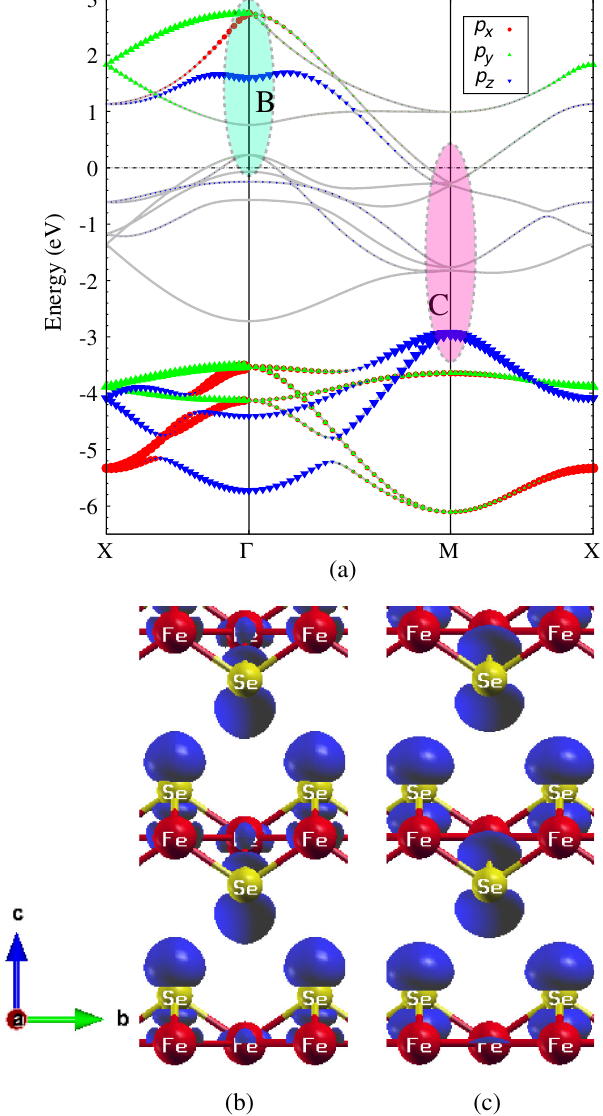
FIG. 3. (a) The calculated band structure of FeSe with the weight of p orbitals of Se. (b) The decomposed charge density of the band at (cid:2) marked by the letter B (antibonding states). (c) The decomposed charge density of the band at M marked by the letter C (bonding